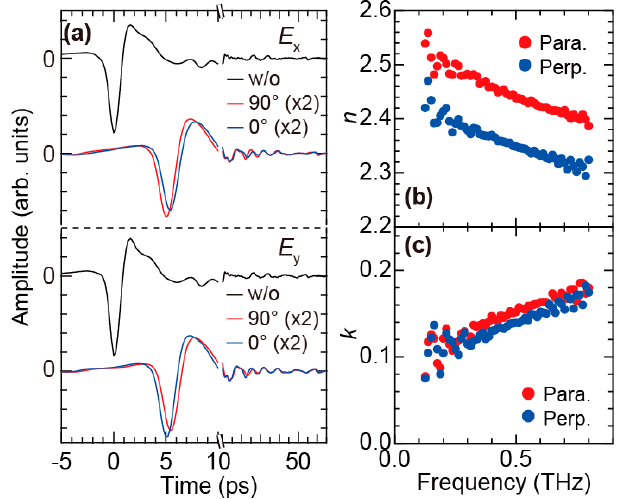
Figure 3. (a) x- (top panel) and y -components (bottom panel) of the terahertz E-field time-domain waveform without (black curves) and with the FKM sample for sample angles of 0° (blue curves) and 90° (red curves); (b) The real and (c) imaginary part of the complex refractive index parallel and perpendicular to the slow optic axis derived from the time-domain waveform in (a). Reproduced from M. Okano et al. Sci. Rep. 6 , 39079 (2016) [25]. Licensed under CC BY 4.0.